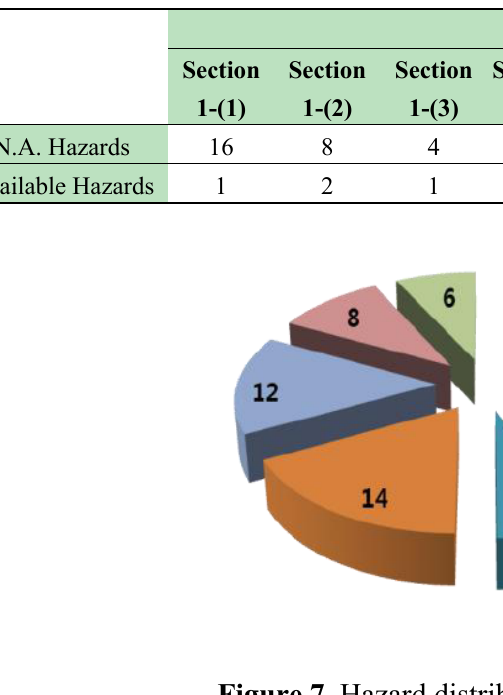
Figure 7. Hazard distribution based on the three